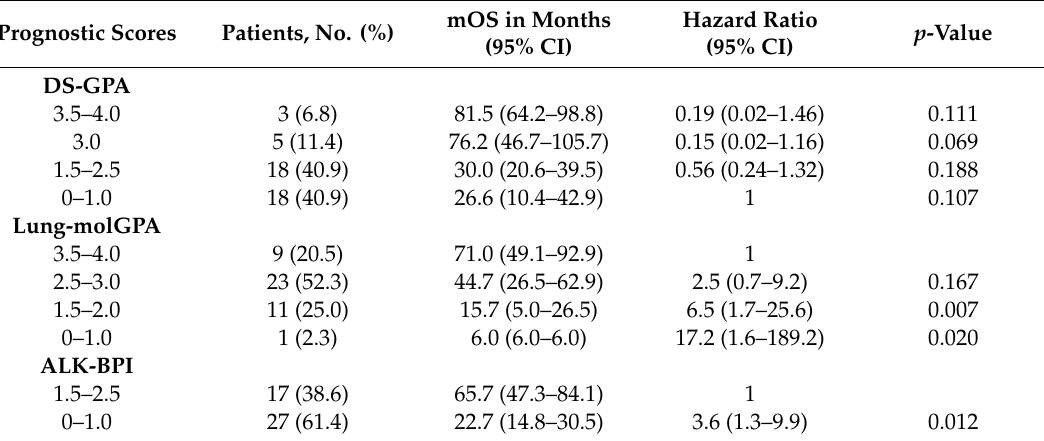
Table 4. Univariate Cox regression OS analysis of DS-GPA, Lung-molGPA and